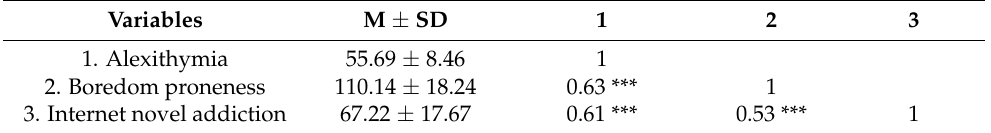
Table 2. Means, standard deviation and correlations between all variables ( N =